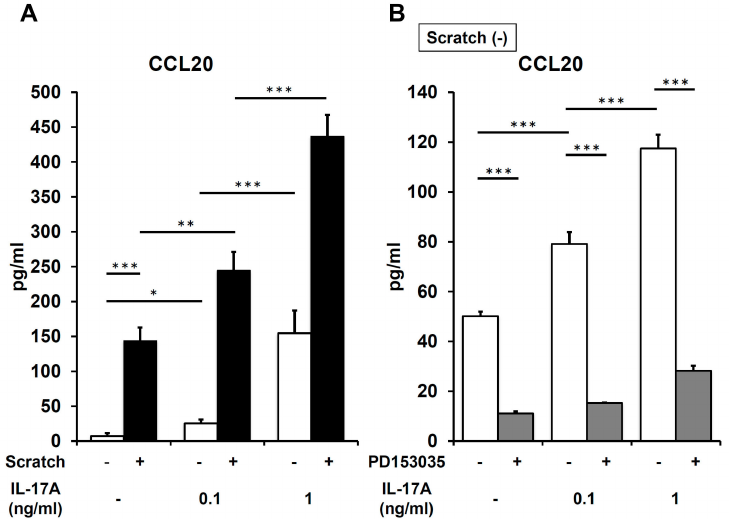
Figure 6. IL-17A augments scratch-induced CCL20 upregulation at 3 h after scratching. ( A ) CCL20 production was measured in non-scratched control and scratched keratinocytes in the presence or absence of IL-17A (0.1 or 1 ng / mL). ( B ) Non-scratched keratinocytes were stimulated with IL-17A (0.1 or 1 ng / mL) with or without PD153035 (EGFR inhibitor, 300 nM). Representative data of three